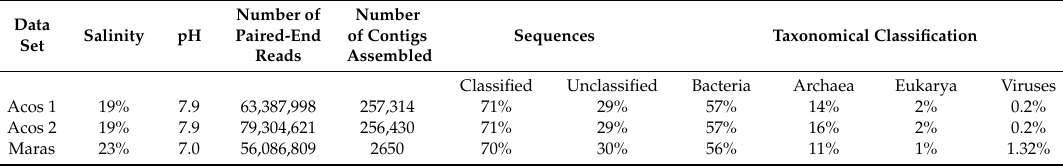
Table 1. Sequence features of hypersaline metagenomes from Cusco, Peru.